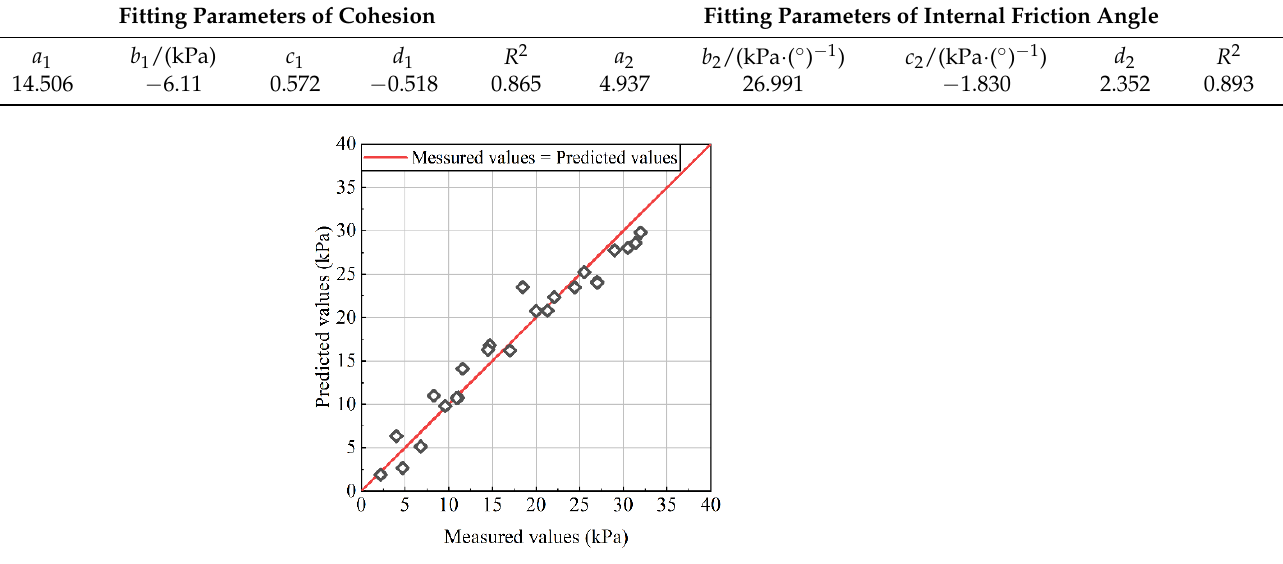
Table 3. Fitting results of sandy-gravel soil.